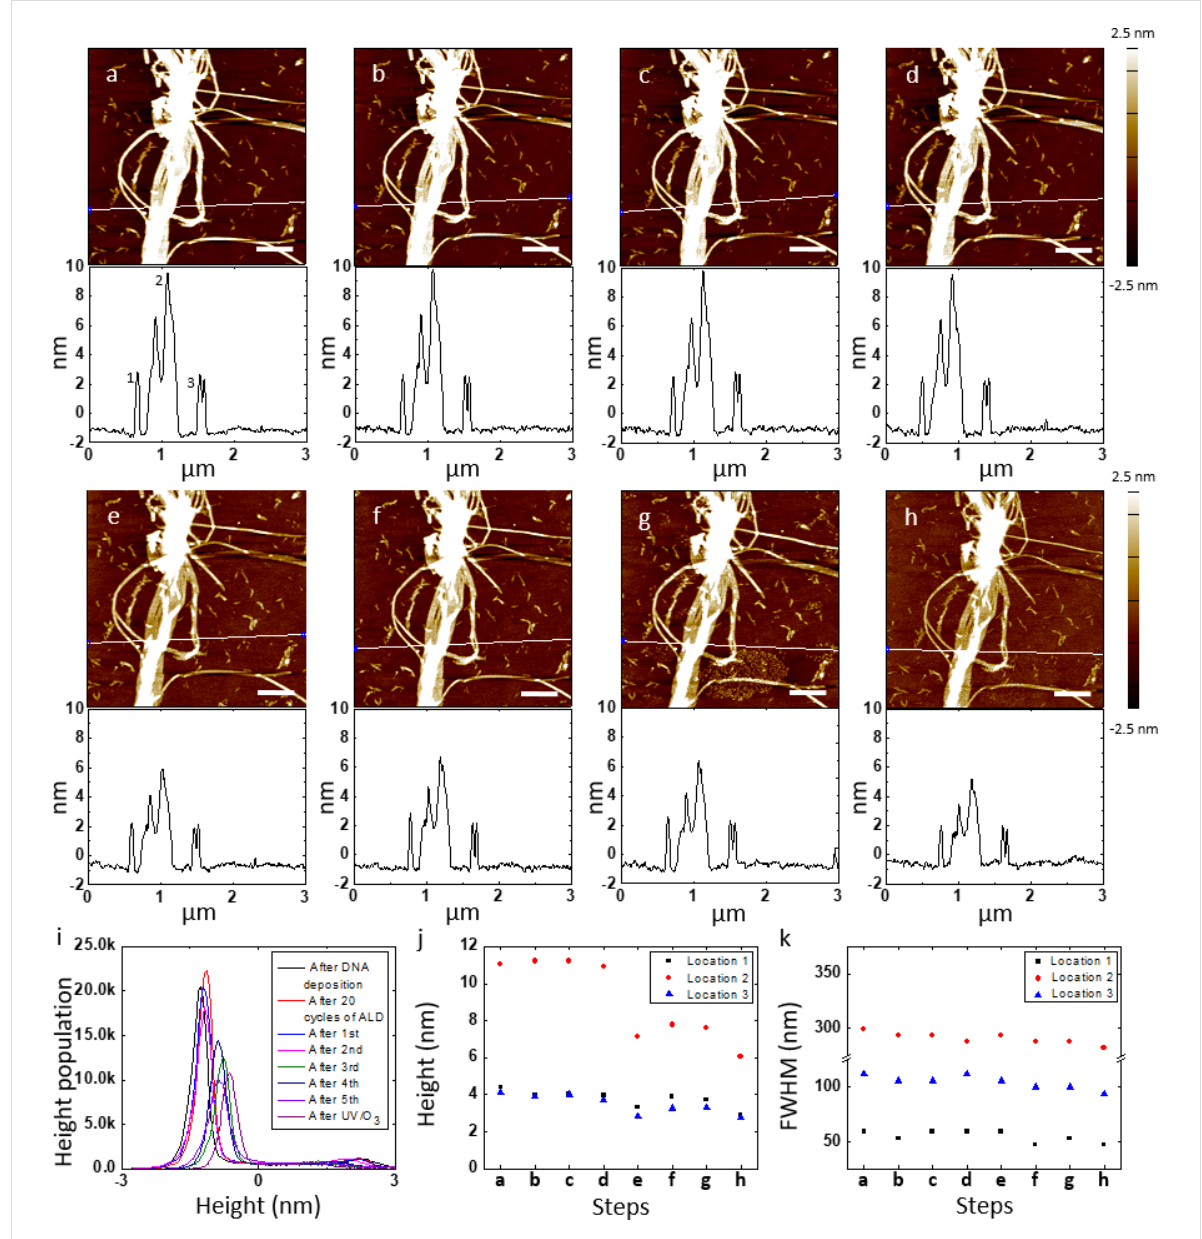
Figure 3: Stability of a DNA nanotube master template with a ca. 2 nm thick Al 2 O 3 film for multiple pattern transfers to PLLA stamps. AFM height images and corresponding cross-sectional analysis of DNA nanotubes in the same location after (a) deposited on a silicon wafer, (b) 20 cycles of ALD of Al 2 O 3 , (c) 1st, (d) 2nd, (e) 3rd, (f) 4th, and (g) 5th pattern transfer to PLLA stamps, and (h) UV/O 3 treatment for 1 h and washing with DI water. White lines on the AFM images indicate where the cross-sections were determined. (i) Histograms of the AFM height images from (a) to (h). (j) Height and (k) FWHM of the DNA nanotubes in three different locations of the AFM images from (a) to (h). Locations 1, 2, and 3 correspond to 1, 2, and 3 in the cross-section of the AFM image (a). Scale bars represent 500 nm. Note: The DNA master template was contaminated before the 5th spin coating of PLLA in dichloromethane solution. The AFM images (a) and (b) are also shown in Figure 2. The enlarged version of the histograms in (i) is avail- able in Figure S3 (Supporting Information File 1).